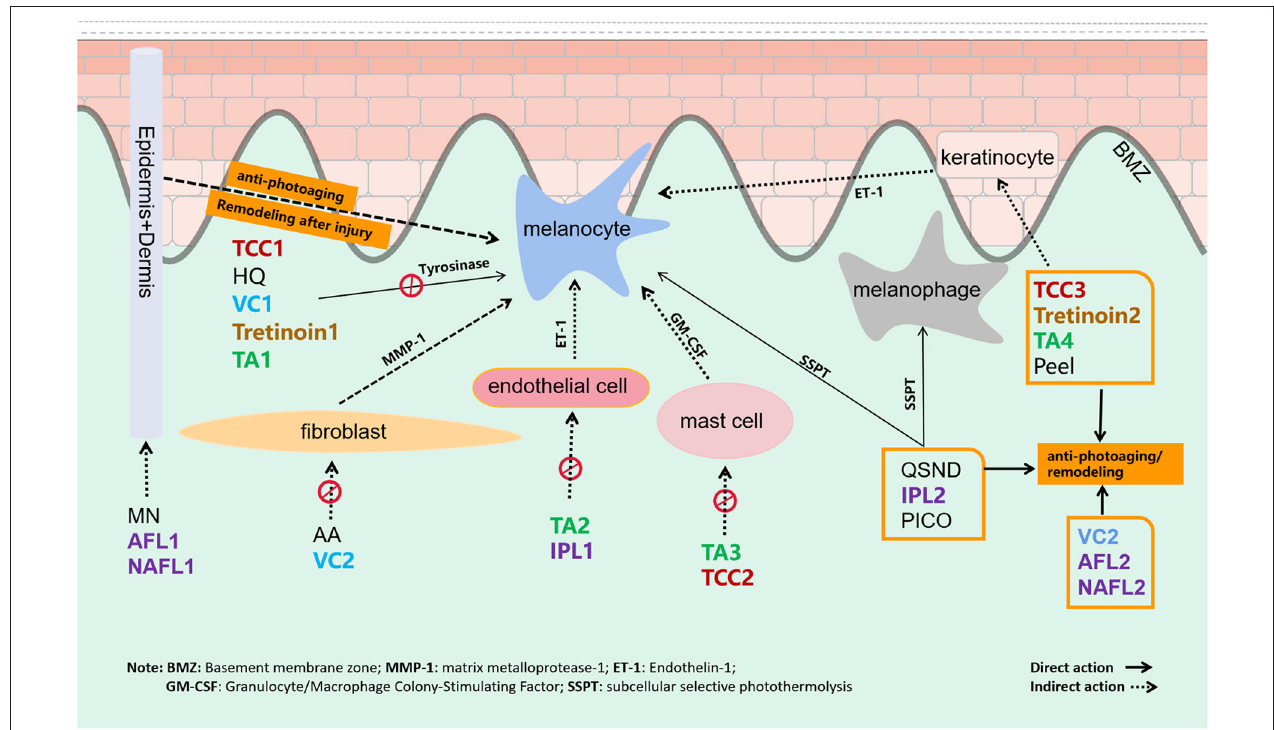
FIGURE 8 | The target and mechanism of 14 common interventions for melasma are involved in this study.